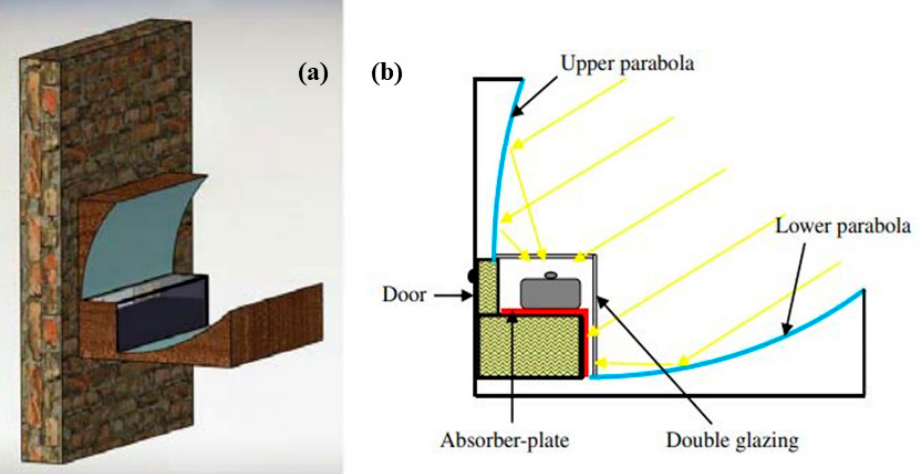
Figure 9. ( a ) SC unified into a building wall; ( b ) Schematic diagram of a solar cooker in asymmetric line. Reprinted/adapted with permission from Ref. [34] 2013, Elsevier.